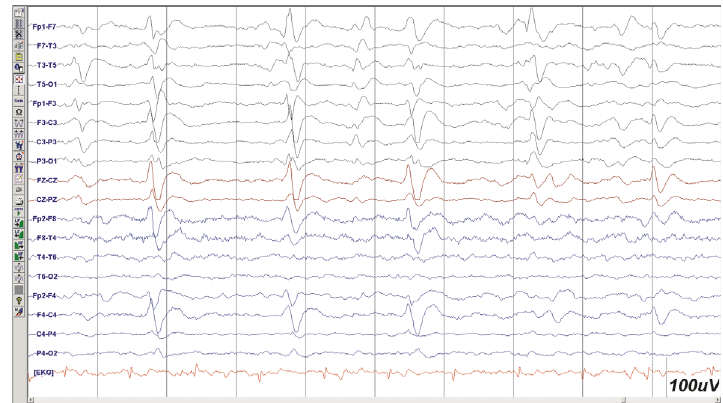
Figure 2: The second EEG performed 25 days after the initial EEG showed severe slowing of background activity and periodic sharp-wave complexes with triphasic morphology at a rate of 0.5 Hz. Calibration: 1 s between vertical lines and 100 𝜇 V per vertical unit. Low filter: 1 Hz; high filter: 35 Hz; notch filter: 50